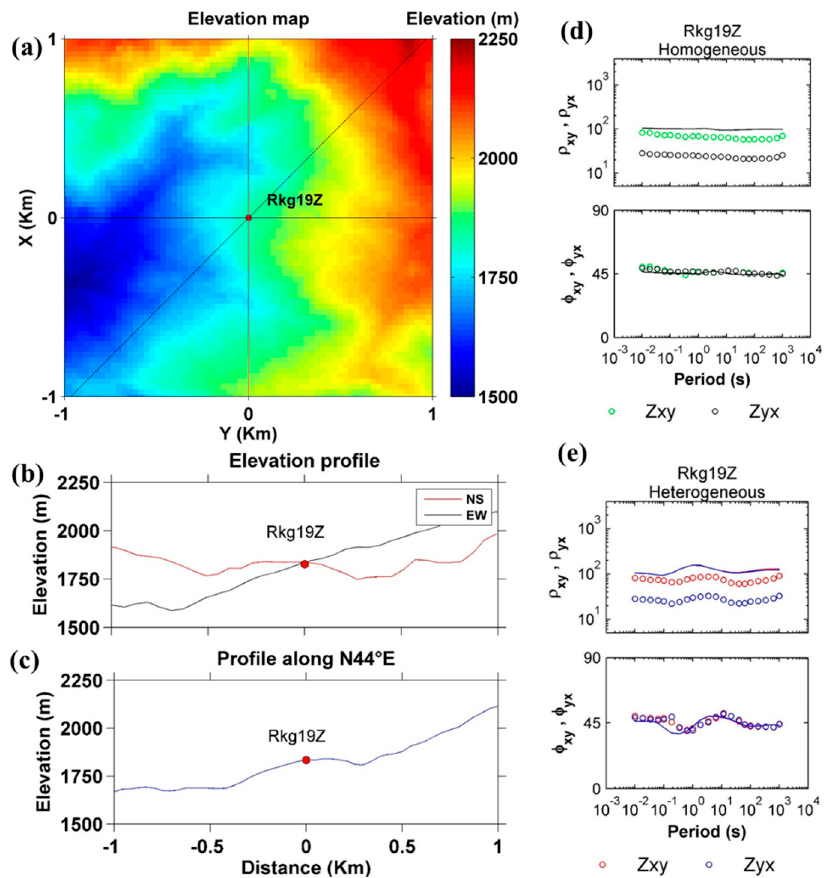
Figure 10. ( a ) The elevation map around site 19. ( b ) Elevation profile along the NS, EW and the direction of maximum elevation change ( c ). ( d ) The comparison of MT response of off-diagonal components generated by ( d ) homogeneous half-space model and ( e ) heterogeneous model. Site 31 is located in the inner LH region at an altitude of 1226 m. The elevation and slope vary from 1226 m to 1564 m and from − 8 ◦ to 33 ◦ , respectively, within 1 km distance from the site. The maximum variations in the elevation are along the N 35 ◦ E